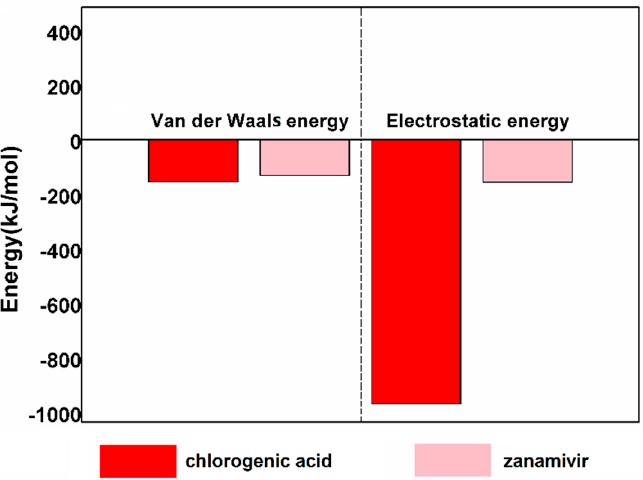
Figure 11. The difference of binding energy contribution from van der Waals and electrostatic energy in the NanA–chlorogenic acid and NanA–zanamivir complexes.